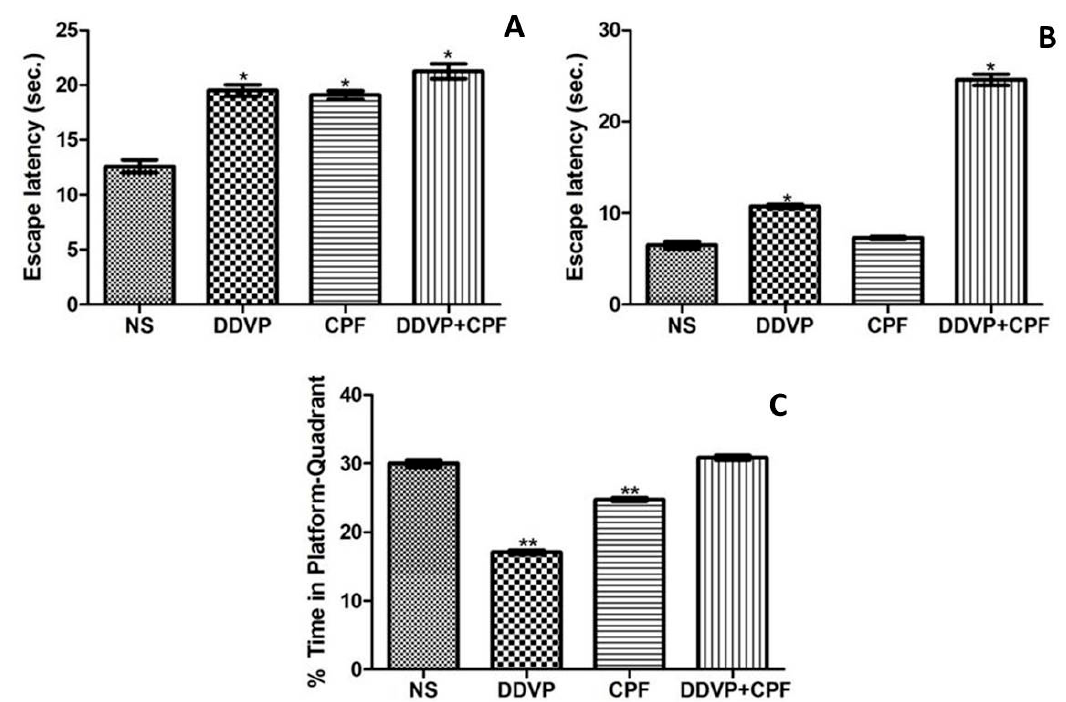
Figure 2. Exposure to DDVP and CPF impaired long-term memory (LTM), short-term memory (STM), and reference memory ( A ) Long-term memory (escape latency); ( B ) Short-term memory (escape latency); and ( C ) Reference memory (% time in the platform-quadrant) tests in the Morris water maze (MWM) paradigm. Double asterisks (**) indicate a significant ( p ≤ 0.05) reduction when compared with NS and DDVP+CPF rats (Figure 2C), while a single asterisk (*) indicates a significant ( p ≤ 0.05)